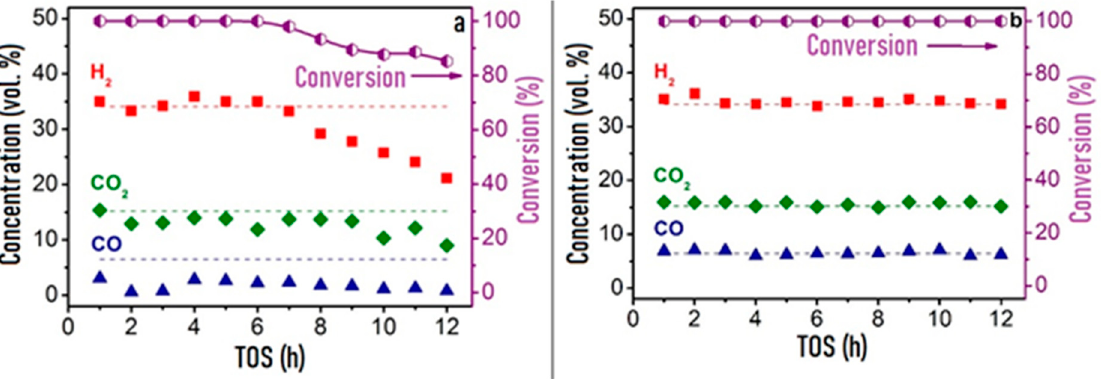
Figure 9. The time ‐ on ‐ steam dependence of HD conversion under ATR conditions: WHSV 30,000 cm 3 g − 1 h − 1 ( a ) and 90,000 cm 3 g − 1 h − 1 ( b ), T = 650 °C, H 2 O/C = 2.5, O 2 /C= 0.5 over Rh/CZB ( a ) and 30,000 cm 3 g − 1 h − 1 ( a ) and 90,000 cm 3 g − 1 h − 1 ( b ), T = 650 ◦ C, H 2 O/C = 2.5, O 2 /C= 0.5 over Rh/CZB ( a ) Rh/CZB/FCA ( b ) catalysts.Adapted from [50]. and Rh/CZB/FCA ( b ) catalysts.Adapted from